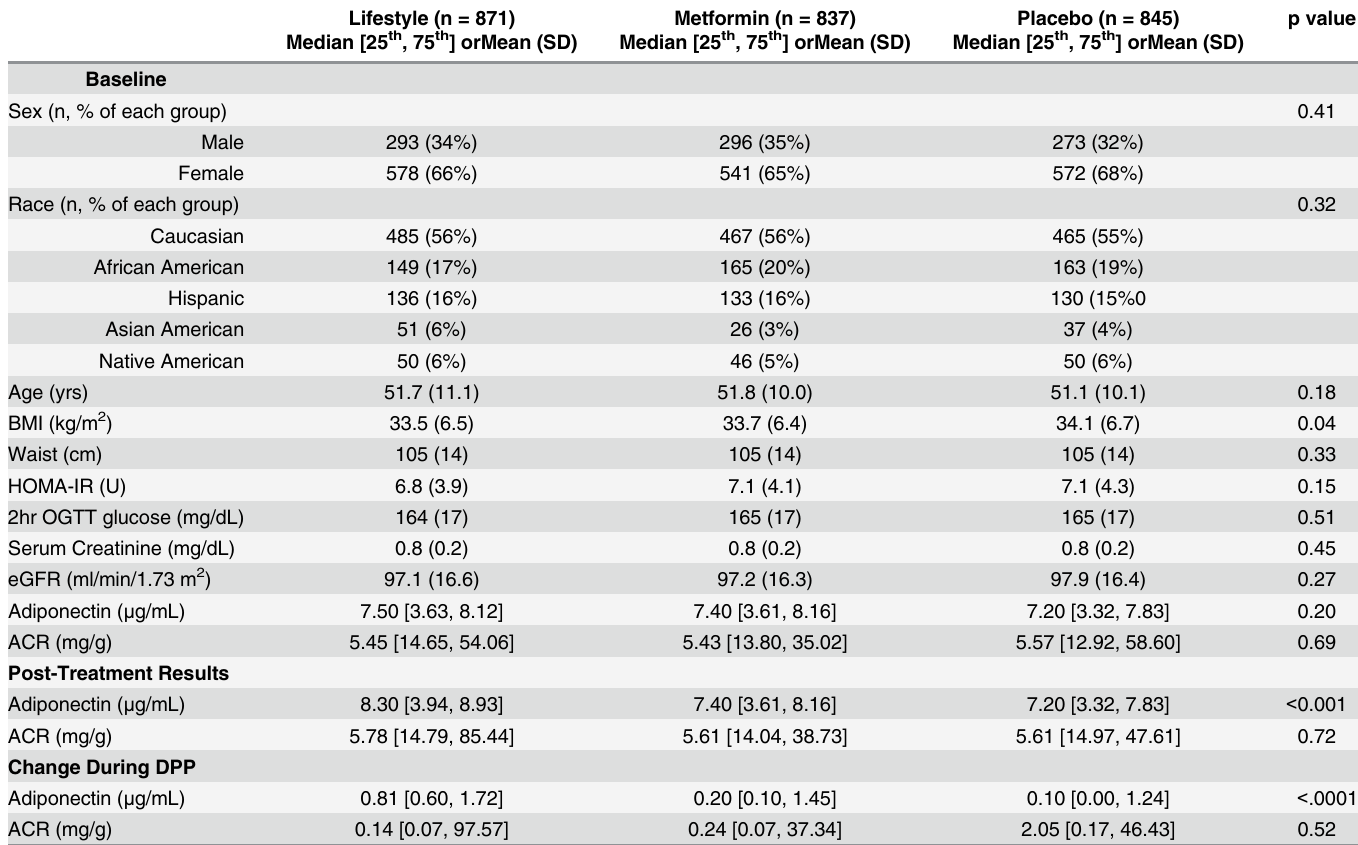
Table 1. Characteristics of the DPP cohort with evaluable adiponectin and albuminuria data at baseline and follow-up. The change in adiponectin was calculated as Year 1 minus Baseline. The change in ACR was calculated as DPP-end minus baseline (see Methods). The p value is for comparisons of each variable across the three treatment